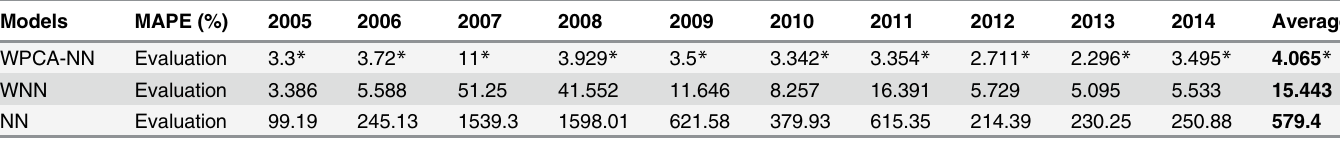
Table 6. Moreover, results of the networks of the WPCA-NN and WNN are valid and reliable for the period of study. Based on the best-performing networks in KOSPI results (Table 2), 3 or